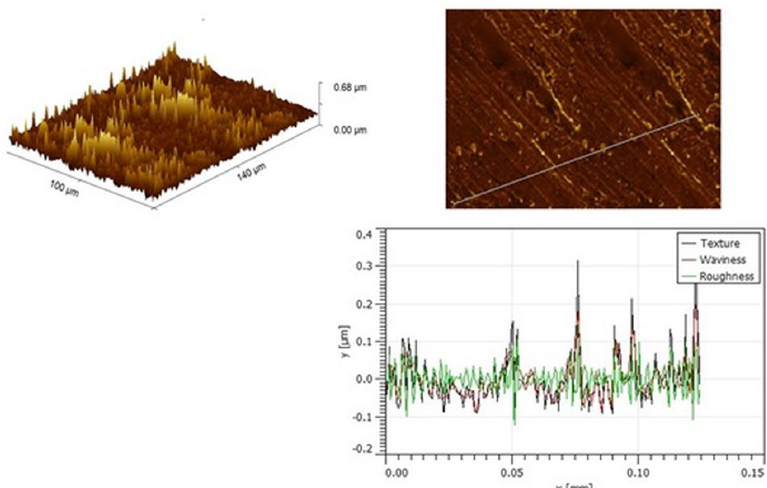
Figure 7. AFM images for the specimen 2 (20N of Load, 800 rpm of disc speed, 9 m/sec of velocity and wear rate of 0.0534 mm 3 /min).